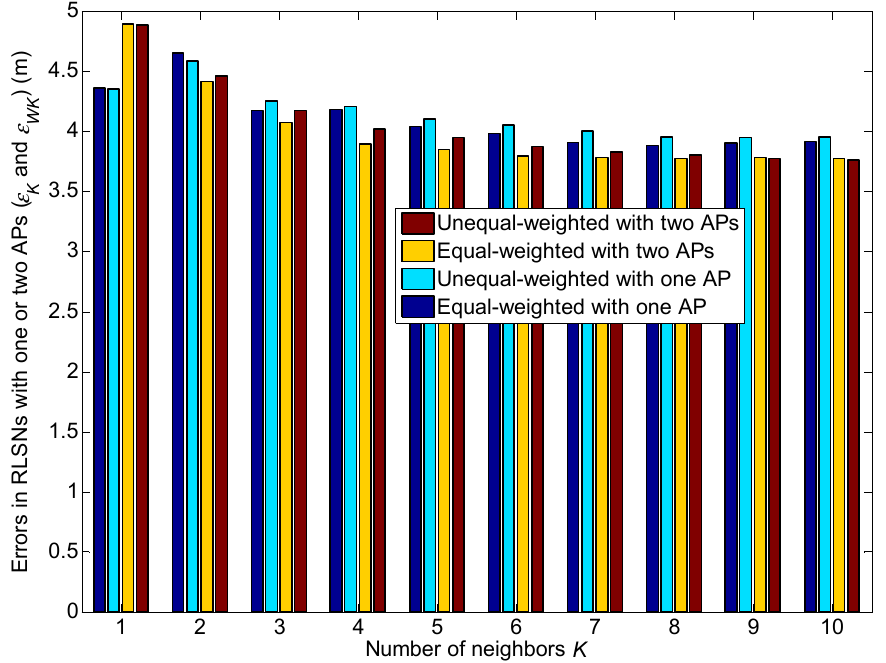
Figure 20. Error comparisons of equal and unequal-weighted RLSNs ( r = 1 m).